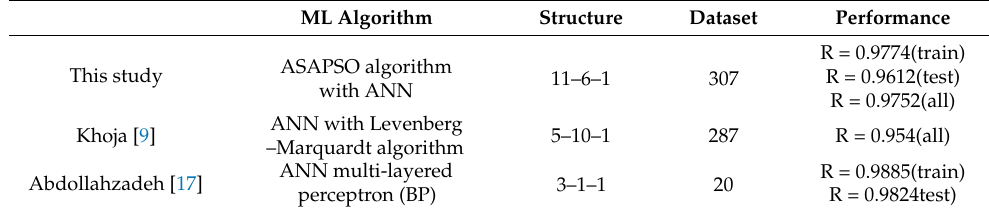
Table 7. Comparison with models in the